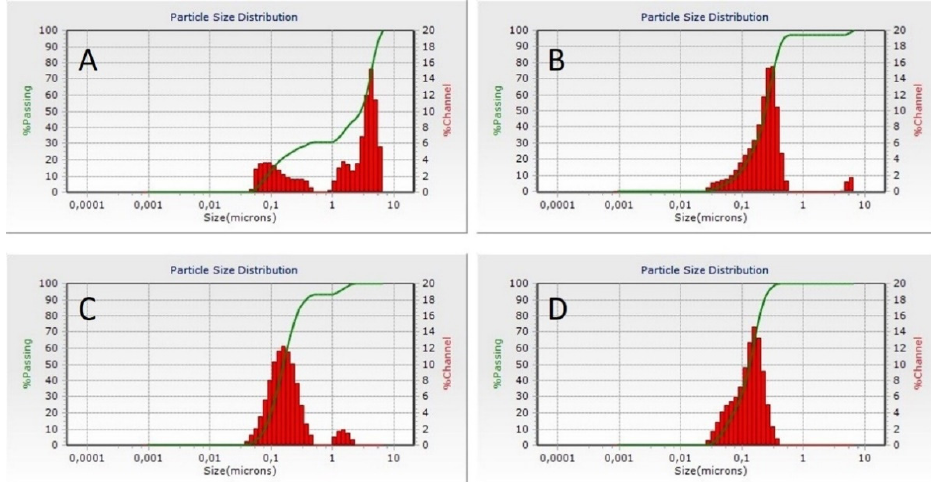
Figure 3. Dynamic light scattering histograms of BZ loaded casein nanoparticles of batches Cas2- Ca3-BZ-1 ( A ), Cas2-Ca3-BZ-2 ( B ), Cas2-Ca3-BZ-4 ( C ) and Cas2-Ca3-BZ-6 ( D ).